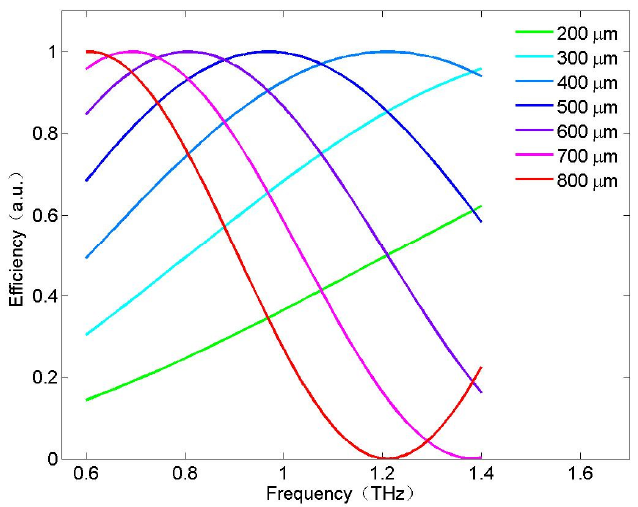
Figure 5. The polarization conversion efficiency at different liquid crystal thicknesses.